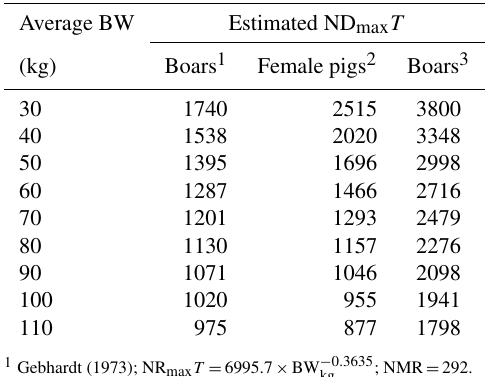
Table 1. Age-dependent ND max T [mgN(BW 0 . 67 fattening pigs with different genders and years as derived from N-balance studies with graded dietary protein supply and approx- imated functions for NR max T depending on body weight (BW).